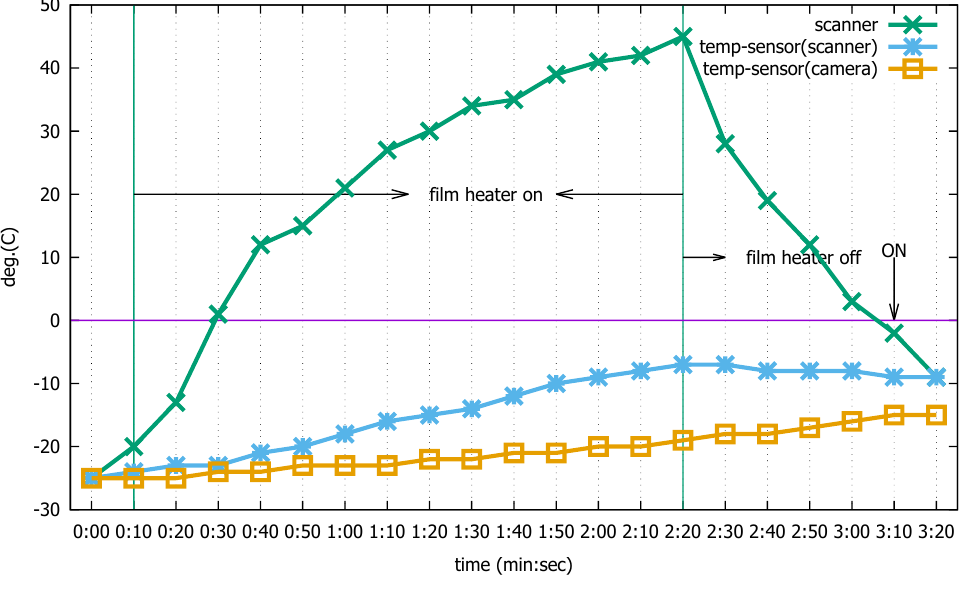
Figure 9. Temperature changes on two sensors when the industrial mobile terminal turns on and then turns off the film heater; without edge artificial intelligence (AI)